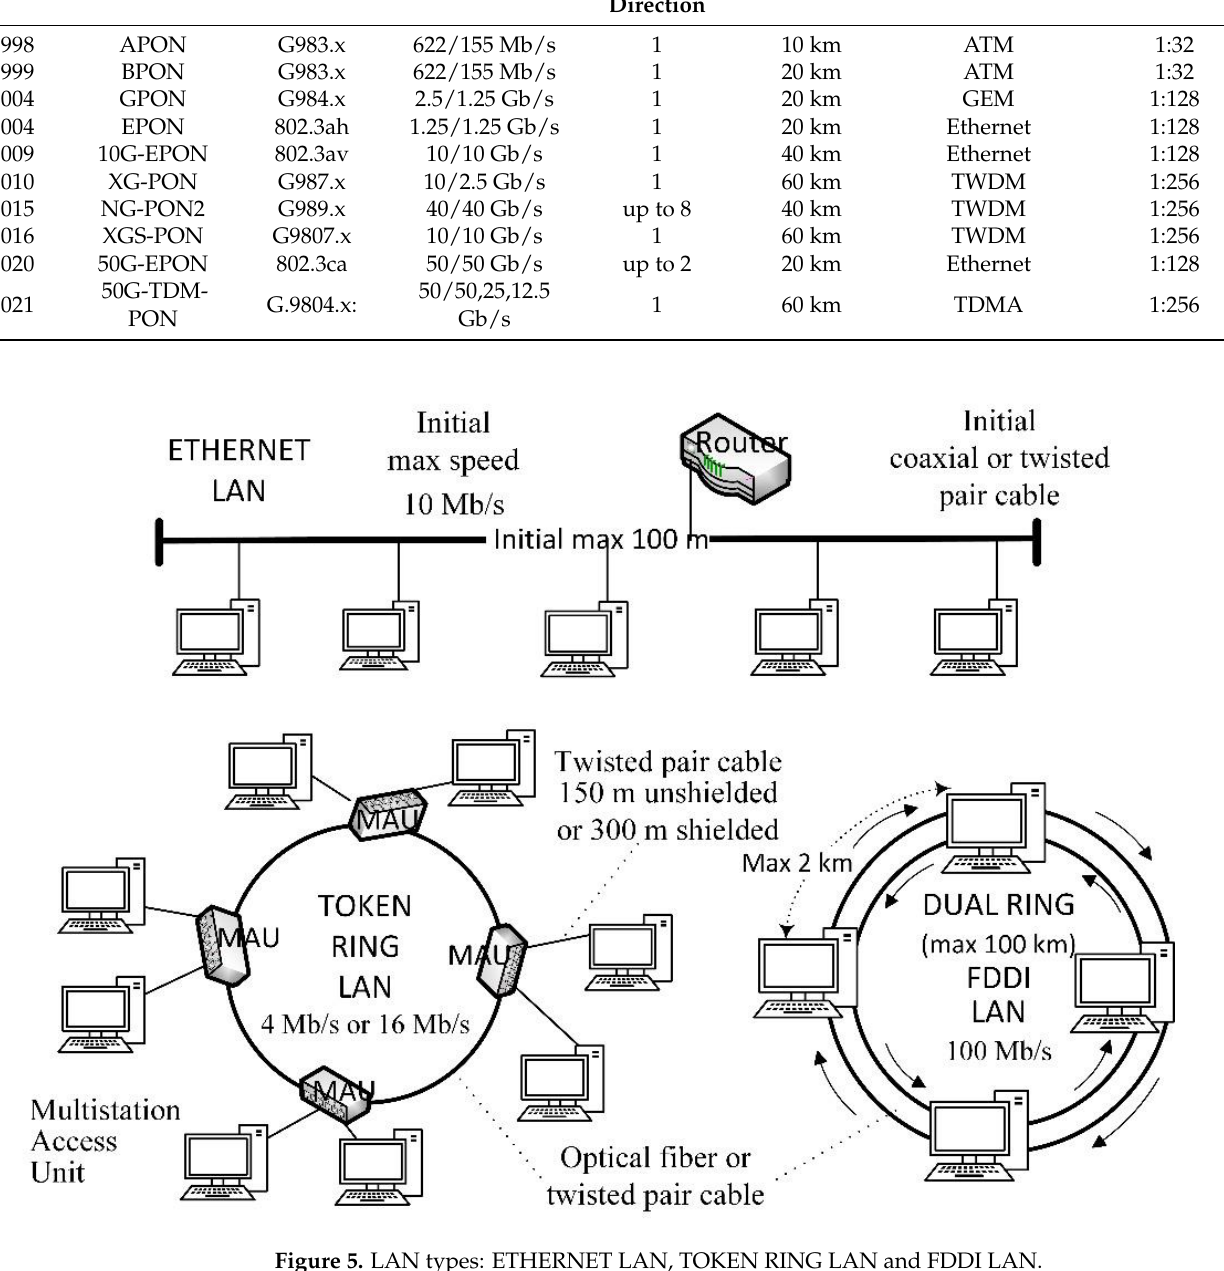
Figure 5. LAN types: ETHERNET LAN, TOKEN RING LAN and FDDI LAN.